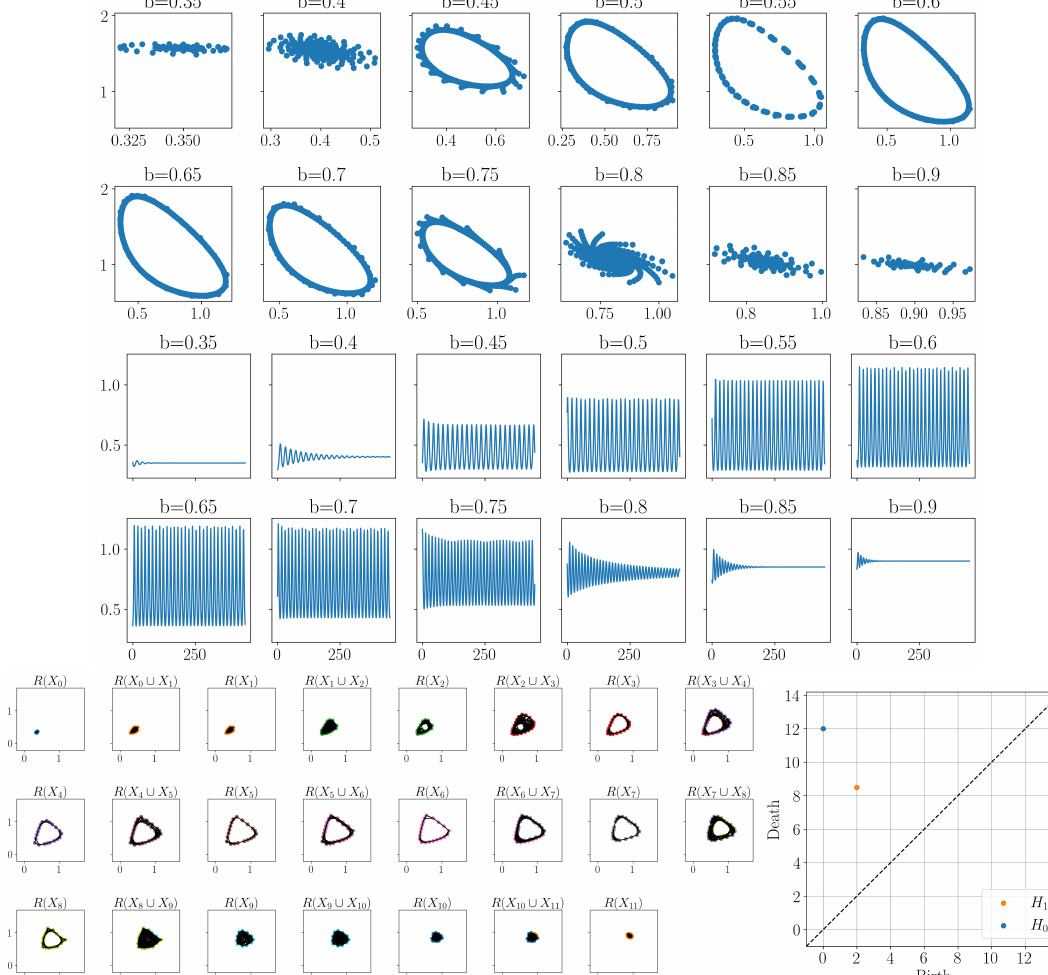
Figure 7. Top: Examples of samplings of the state space of the Sel’kov model for varying parameter value b . Middle: Time series corresponding to only retaining the x -coordinates of the solutions shown in the top figure. Bottom left: zigzag filtration using the Rips complex of the reconstruction with fixed radius of 0.25. Note that 2-simplices are not shown in the complexes. Bottom right: resulting zigzag persistence